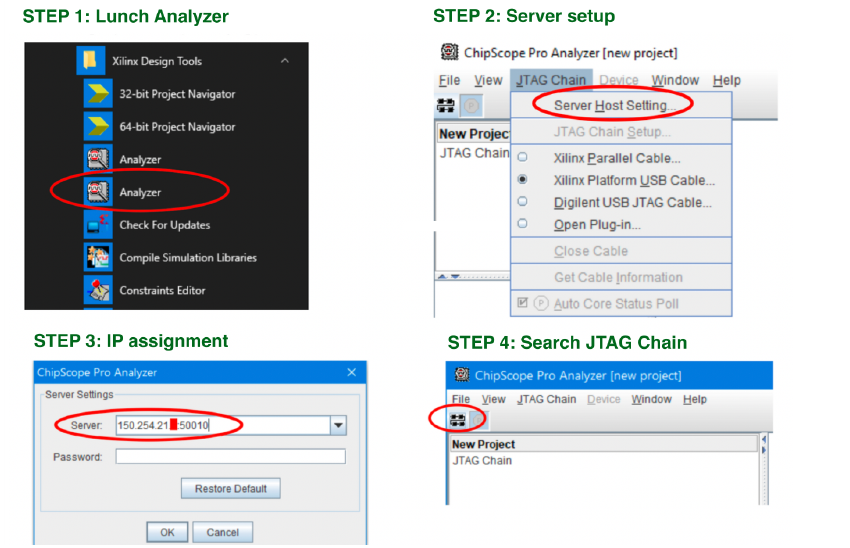
Figure 4. The steps required for remote access (see the text below).